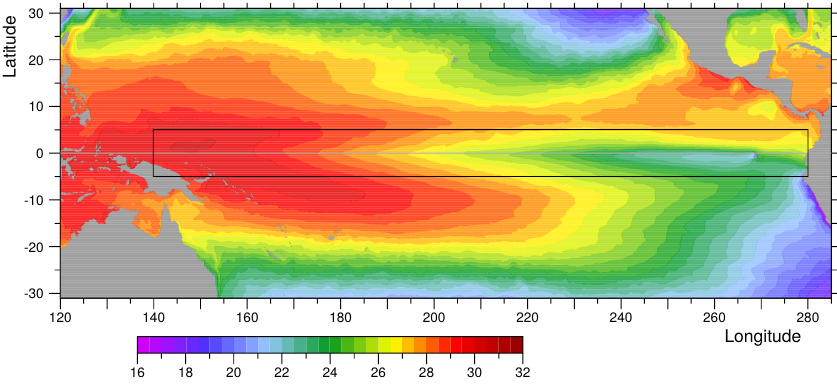
Figure 1. Average model sea surface temperature ( ◦ C) during 1981, showing the averaging region used for Figs. 5 and